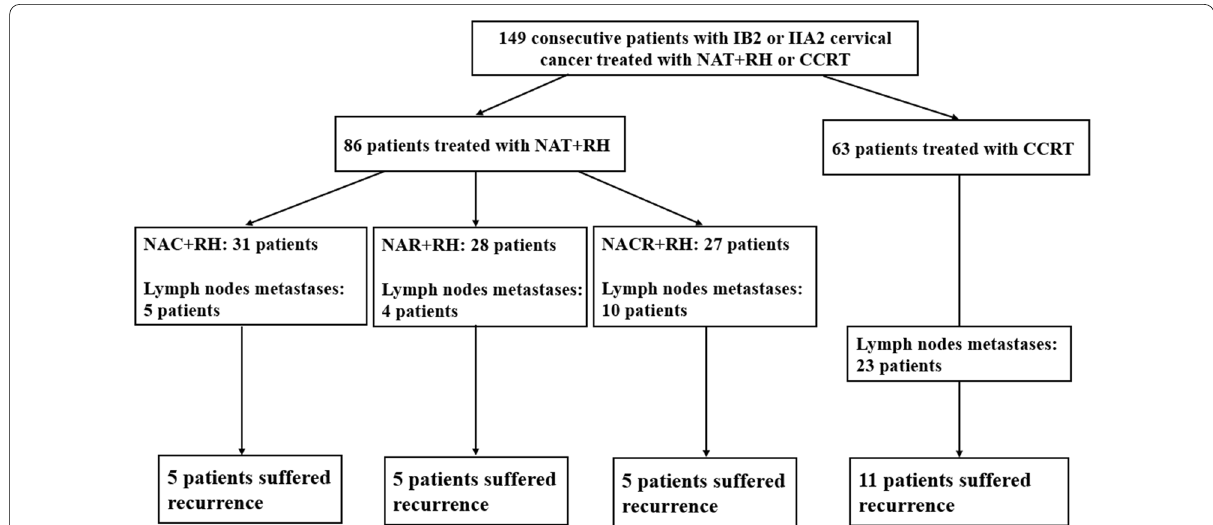
Fig. 3 Flowchart of patients received the various treatment options, lymph node metastasis, and recurrence . NAT followed by radical hysterectomy; NAC, neoadjuvant chemotherapy; NAR, neoadjuvant radiotherapy; NACR, neoadjuvant chemoradiotherapy; CCRT, concurrent chemoradiation